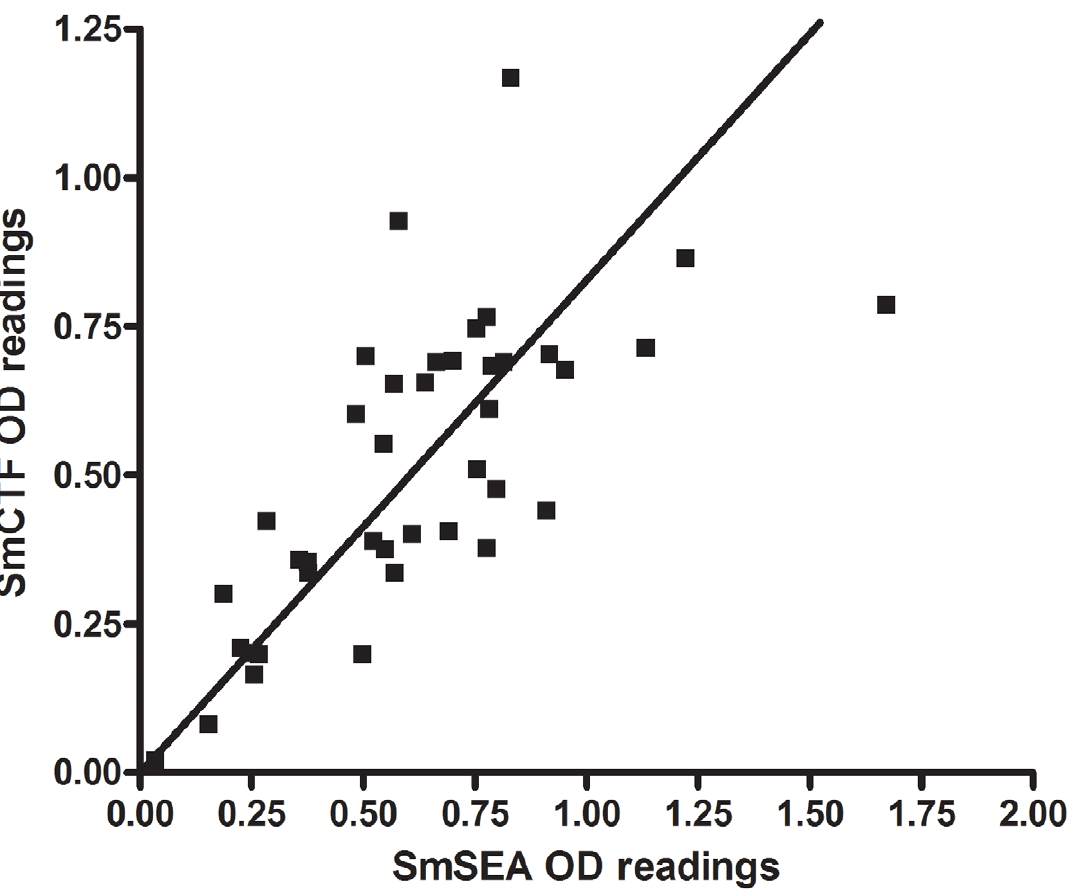
Figure 7. LSTM: correlation between S.mansoni cercarial transformation fluid (SmCTF) and soluble egg antigen (SmSEA) in ELISA. Results for sera from patients infected with S. haematobium .